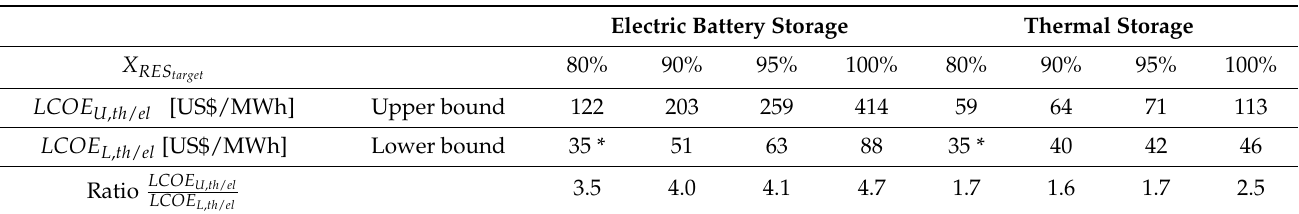
Table 10. Summary of the minimum LCOE values calculated for all configurations. The ratio between the two scenarios is further